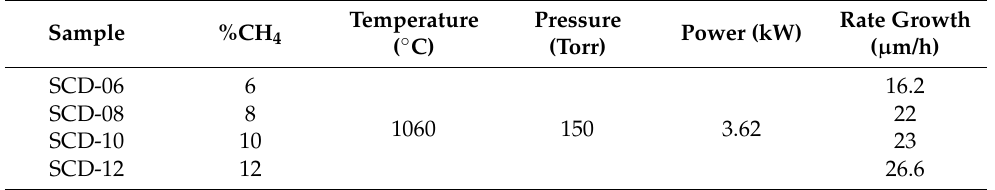
Table 1. SCD growth parameters for different CH 4